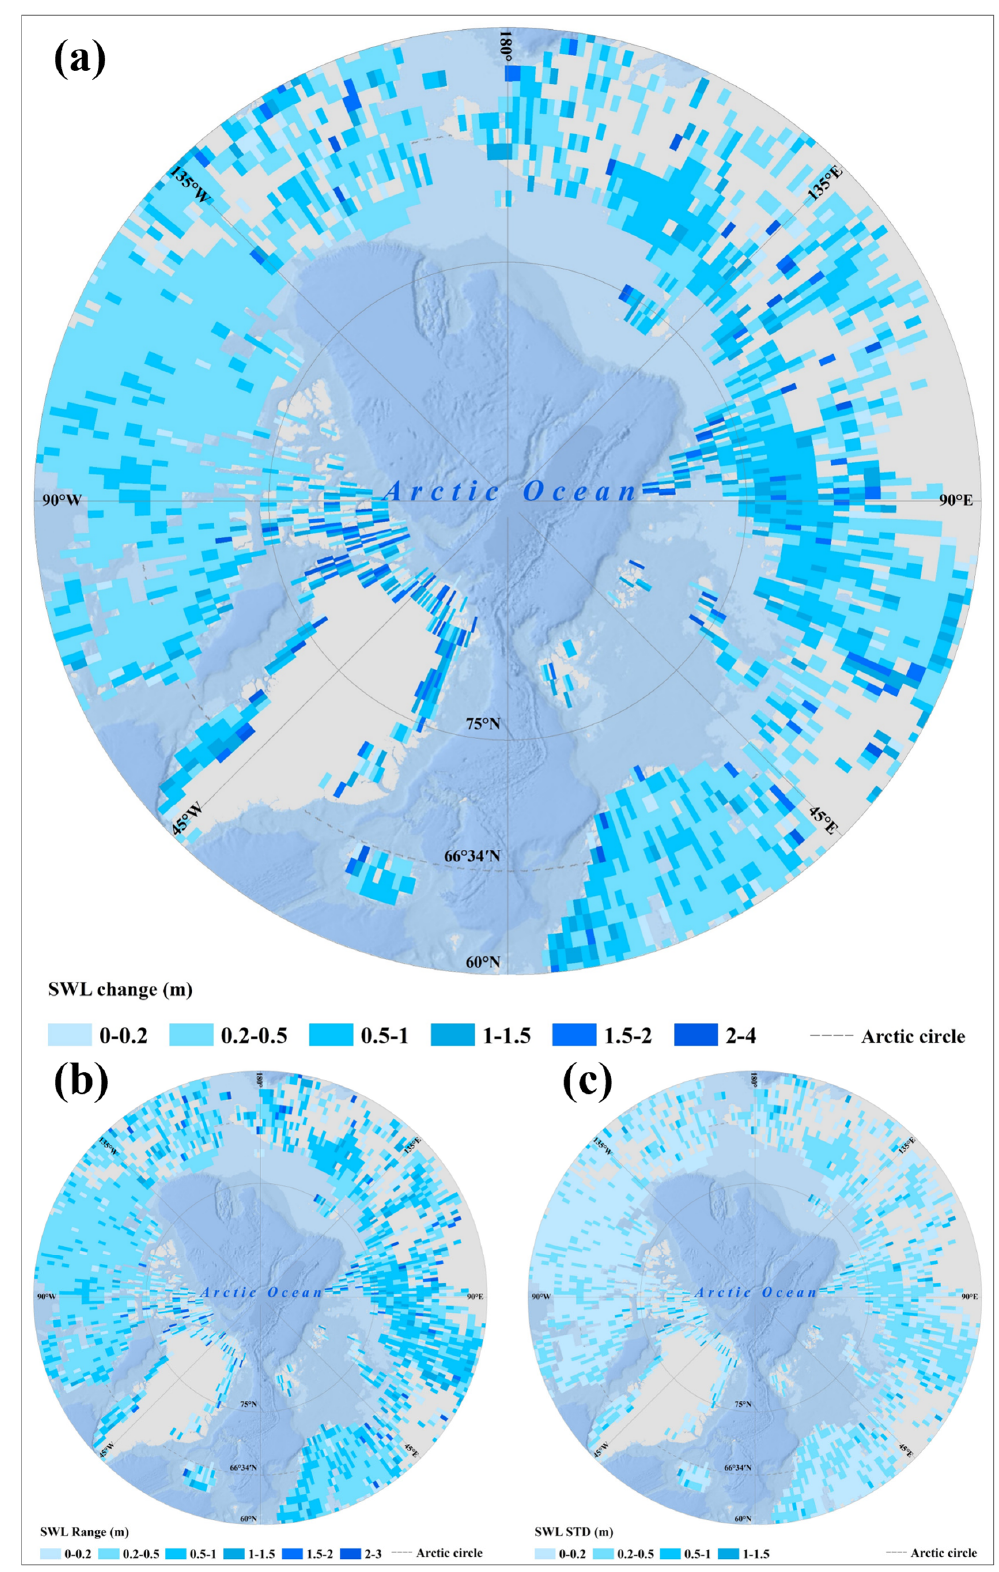
Figure 5. Fishnet-based spatial patterns of seasonal water level variability within three years of observation by the ICESat-2. ( a ) shows the SWL change patterns. ( b ) shows the SWL range patterns. ( c ) shows the standard deviation (STD) patterns of the SWL.